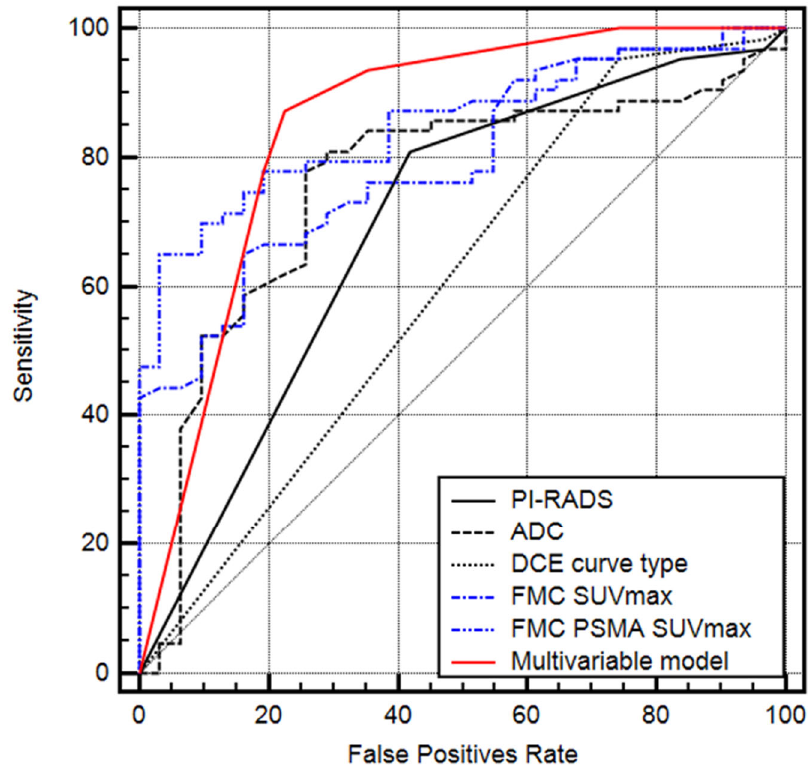
Figure 1. Receiver operating characteristic (ROC) analysis for the single parameters and the multi ‐ variable CHAID model.